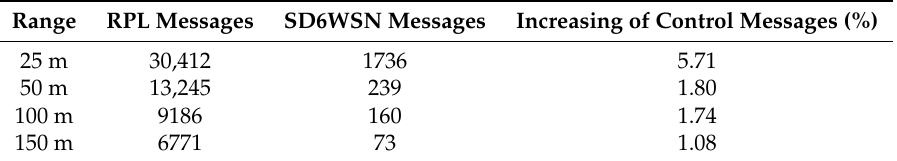
Figure 17. Influence of transmission range in the number of neighbors. Table 5. Increasing of control messages due to SD6WSN.